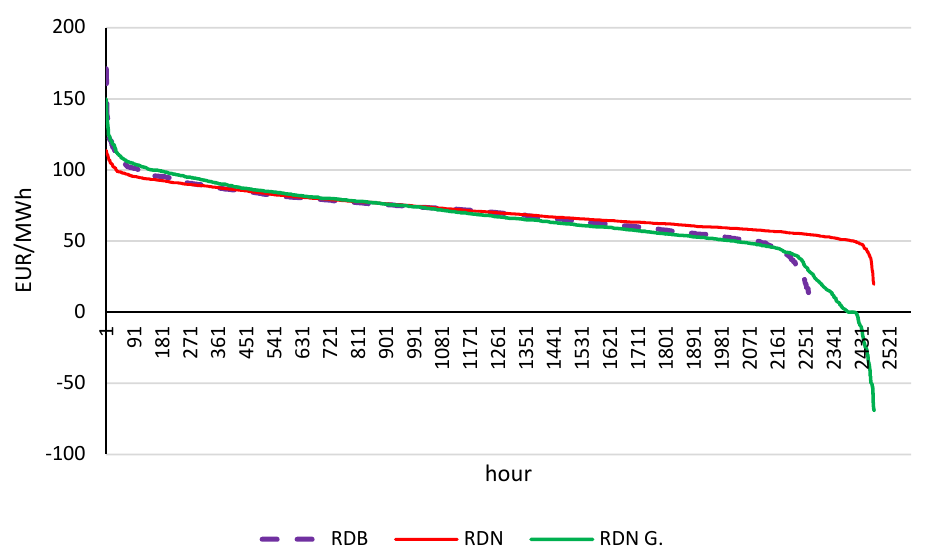
Figure 5. Structured chart of DAM and IDM on POLPX 2021 Warsaw and DAM Germany prices.